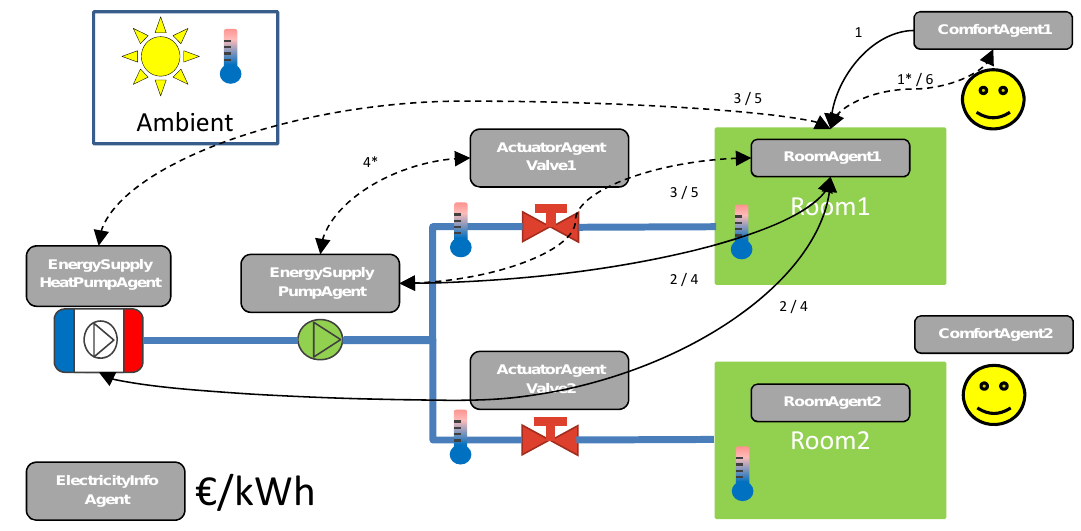
Figure 2. Agents involved in a two room use